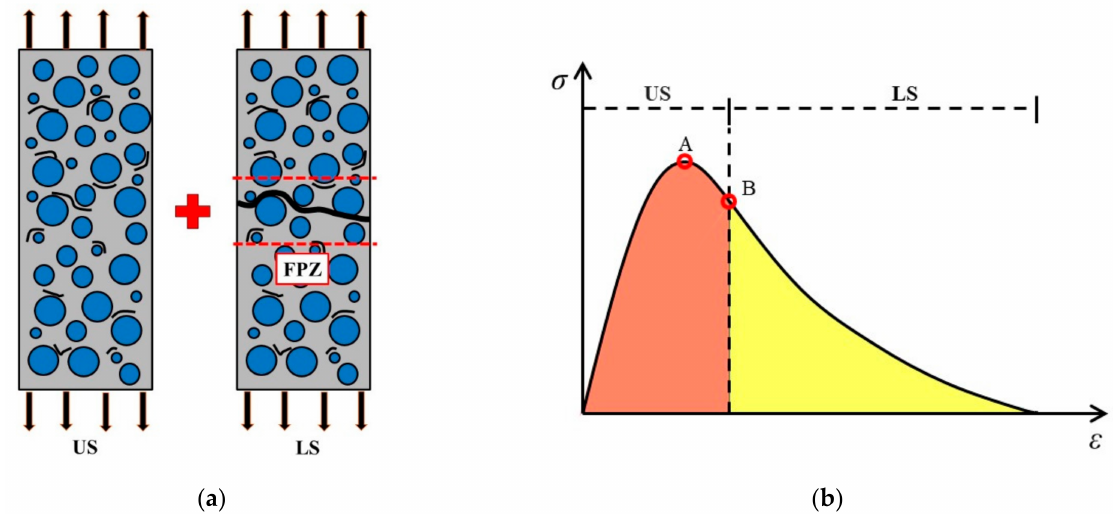
Figure 1. Two-stage feature of macroscopic mechanical behavior of concrete under uniaxial tension: ( a ) deformation-failure process; ( b ) typical nominal stress–strain